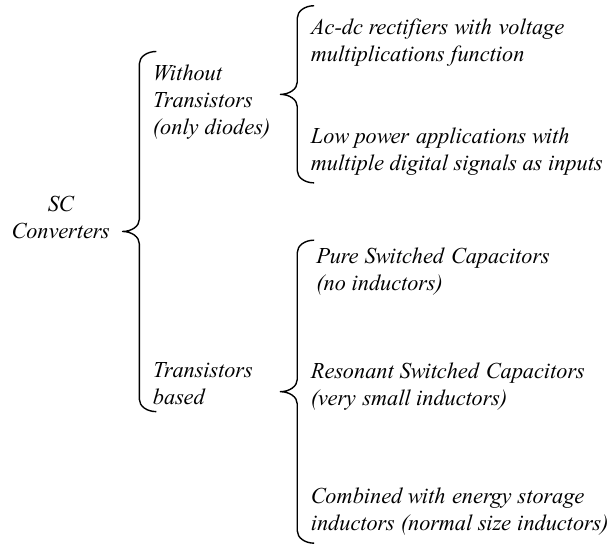
Figure 1. The main classification of SC converters.